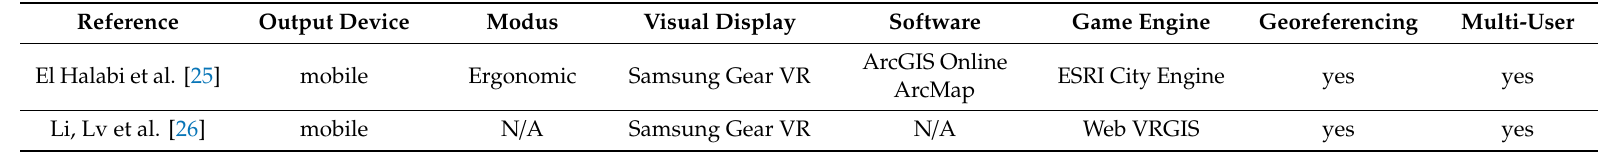
Table A2. Mobile VR Applications with 360 ◦ Panoramas or Videos.